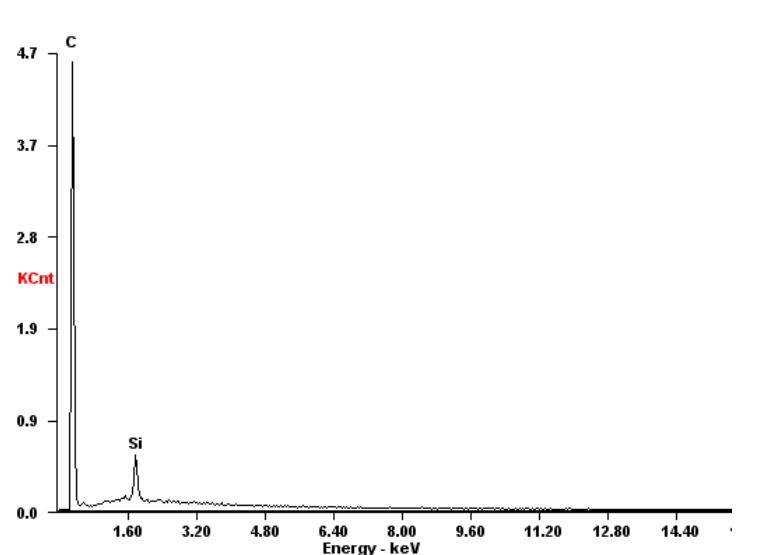
Figure 5. EDX-spectrum of the sintered graphite electrode.